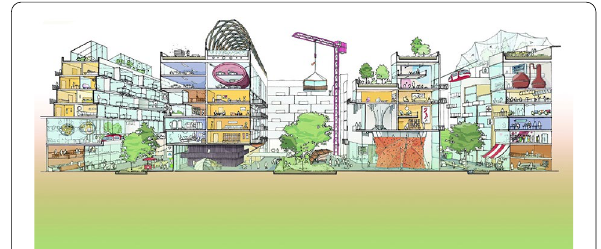
Fig. 6 Artist’s impression of Sidewalk Labs, 2017. © Sidewalk Labs